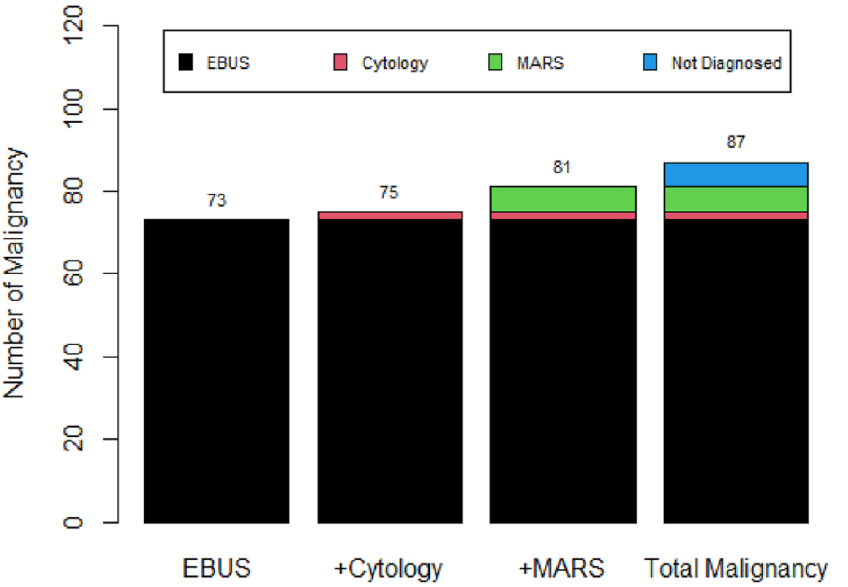
Figure 2. Additional diagnostic yield for malignancy compared to that from R-EBUS-guided TBLB alone. “EBUS” (left-hand bar) represents the number of patients with confirmed lung malignancies after only R-EBUS-guided TBLB. “Total malignancy” (right end bar) represents all malignant cases. Six cases (not diagnosed) among the total malignant cases were confirmed to be malignancies in other ways (for example, via surgical lung resection).